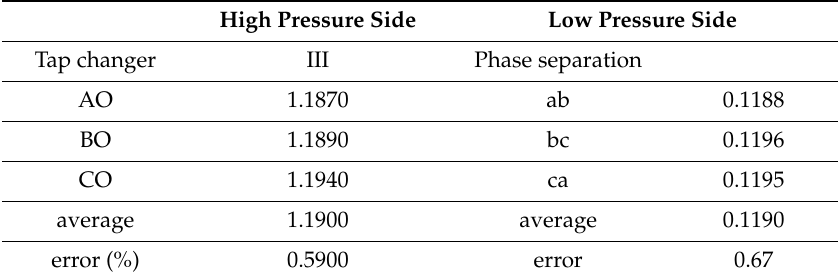
Table 7. DC resistance test of winding (G Ω ).